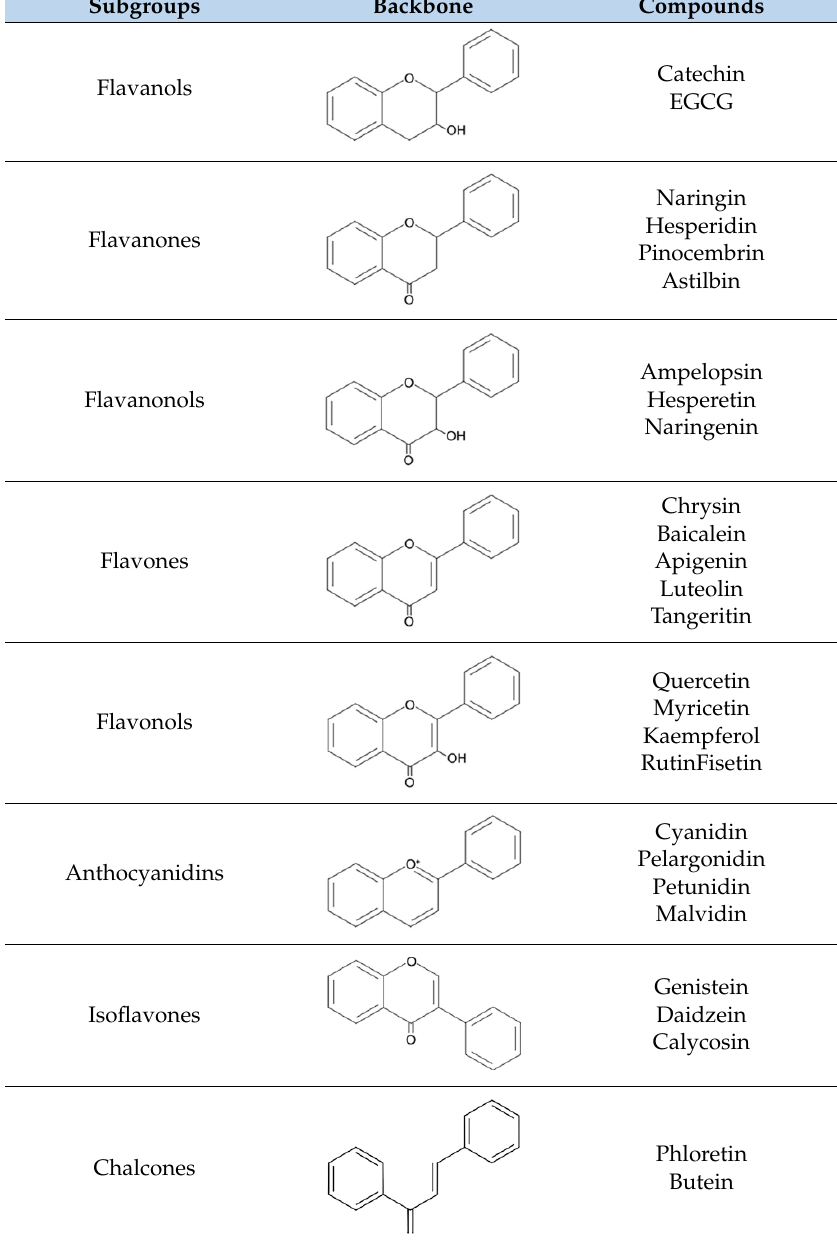
Table 3. A list of flavonoids associated with Parkinson’s disease.